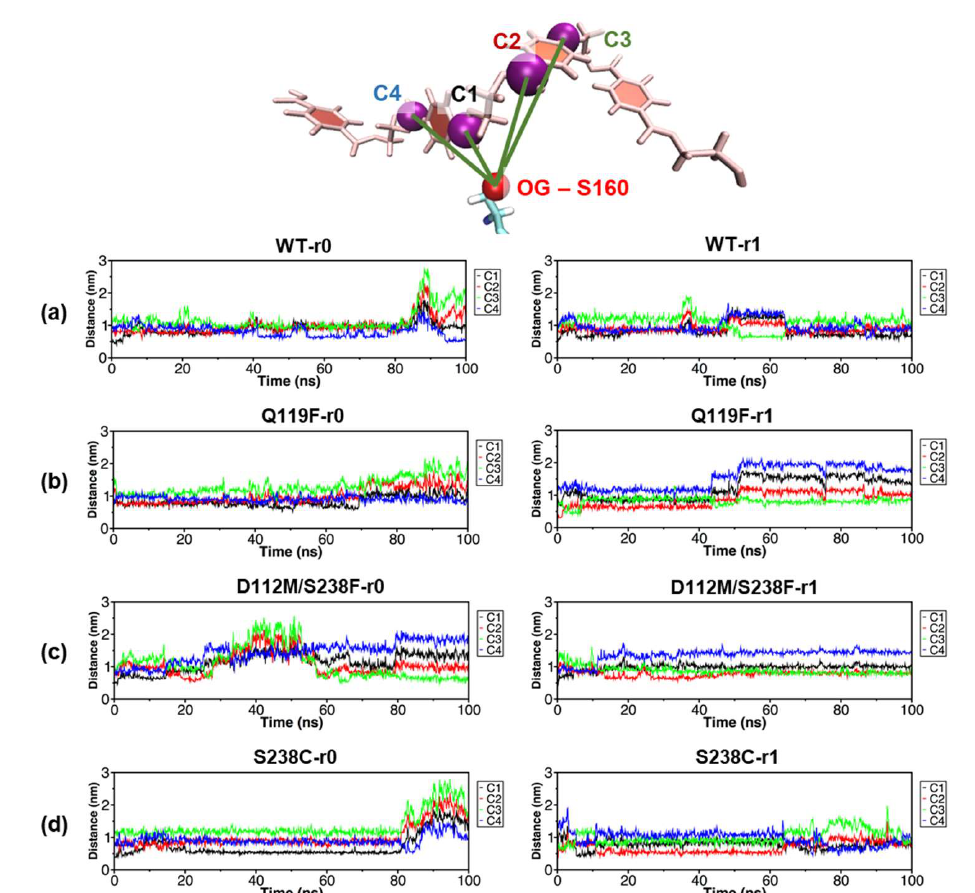
Figure 9. Distance between the catalytic residue S160 and the PET substrate. The distance between the side chain oxygen atom (OG) of the catalytic residue S160 and four carbonyl carbon atoms (C1, C2, C3, and C4) within a PET tetramer was measured from both simulation replicas (r0 and r1) of ( a ) WT, ( b ) Q119F, ( c ) D112M/S238F, and ( d ) S238C.